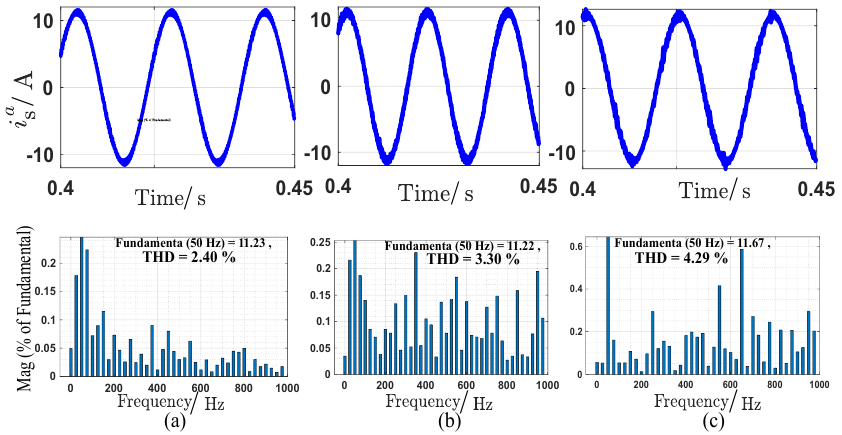
Figure 13. Current THD of the different control strategies at 1500 rpm: ( a ) FOC, ( b ) CPC, and ( c ) Proposed SPC.